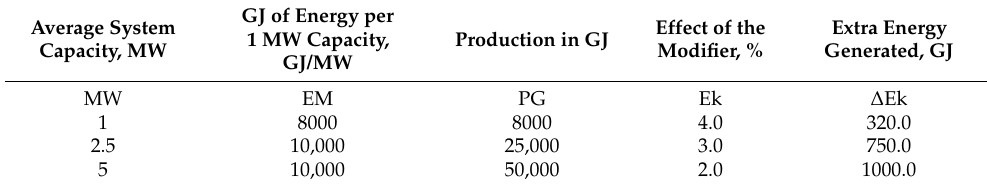
Table 3. Extra energy generated with the modifier for system capacities from 1 MW to 5